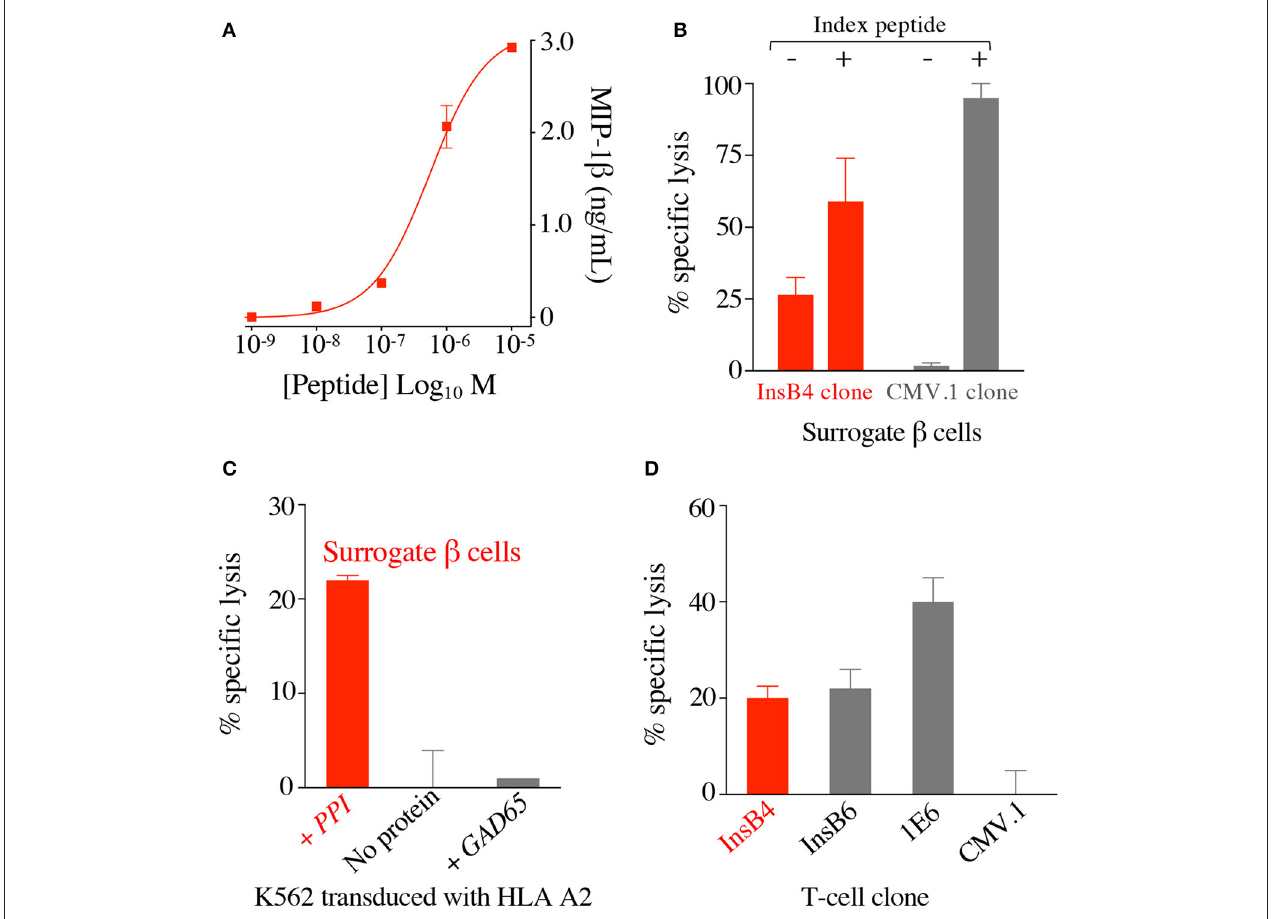
FIGURE 2 | T-cell clone InsB4 recognises a genuine HLA A2-restricted, insulin B-derived epitope presented at the surface of human pancreatic β cells. (A) HLA A2 restricted clone InsB4 grown from a patient with type 1 diabetes recognizes the peptide HLVEALYLV from insulin β chain. InsB4 tested with an increasing concentration of the HLVEALYLV peptide according to the x-axis. Performed in duplicate: overnight incubation and MIP-1 β ELISA. Error bars depict SEM. (B) Surrogate β -cells (K562 transduced with HLA A2 and preproinsulin) were killed by the InsB4 clone. Chromium release cytotoxicity assay at a T-cell to target cell ratio of 3:1 over 5h. CMV.1 (pp65 residues 495–503 from CMV) clone used as an irrelevant control. Exogenous index peptides (10 − 5 M) for each clone were included as positive controls for killing of the surrogate β -cells. Error bars depict SEM. (C) InsB4 specifically killed surrogate pancreatic β -cells as K562s transduced with HLA A2 alone or GAD65 (irrelevant protein) and HLA A2 were not recognised. Chromium release cytotoxicity assay at a T-cell to target cell ratio of 3:1 over 5h. Performed in duplicate with error bars depicting SEM. Assay performed twice with similar results. (D) InsB4 and sister clone InsB6 (expressing the same TCR) kills real